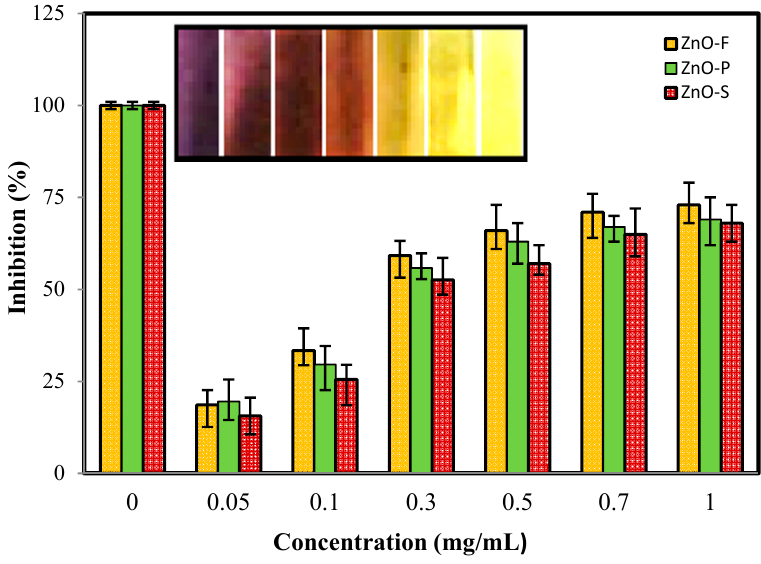
Figure 8. Scavenging capacity of the prepared ZnO samples on 1,1-Diphenyl-2-picrylhydrazyl (DPPH) free radicals and color changes of DPPH with different concentration of ZnO-NPs (inset).